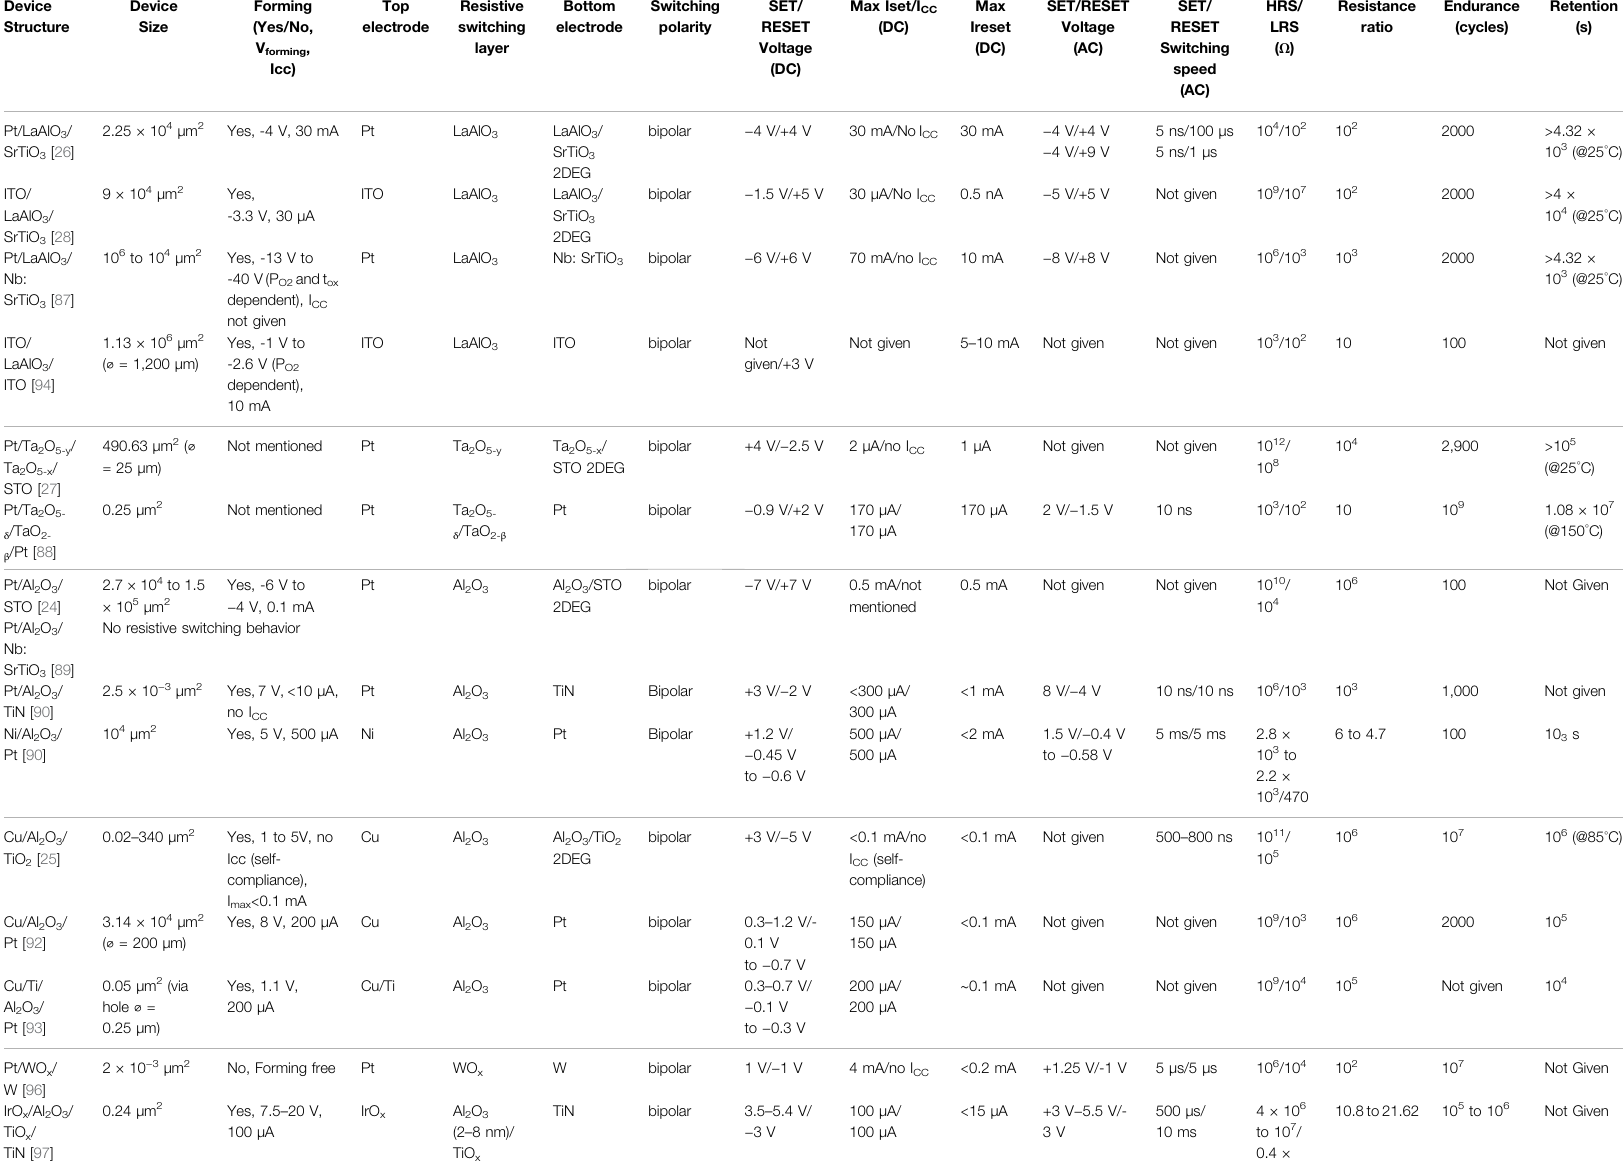
TABLE 1 | Comparison of device performances. Device